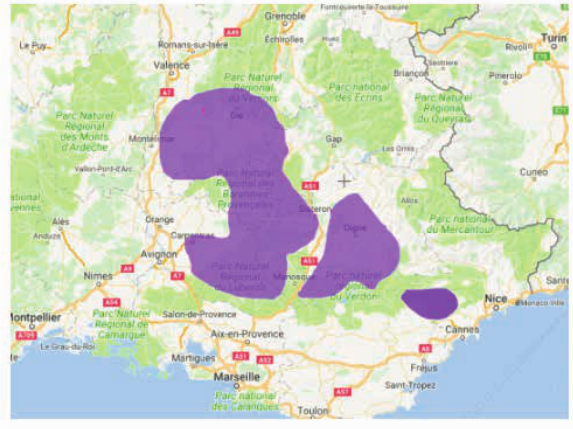
Figure 1: Rough approximation of best areas to see lavender